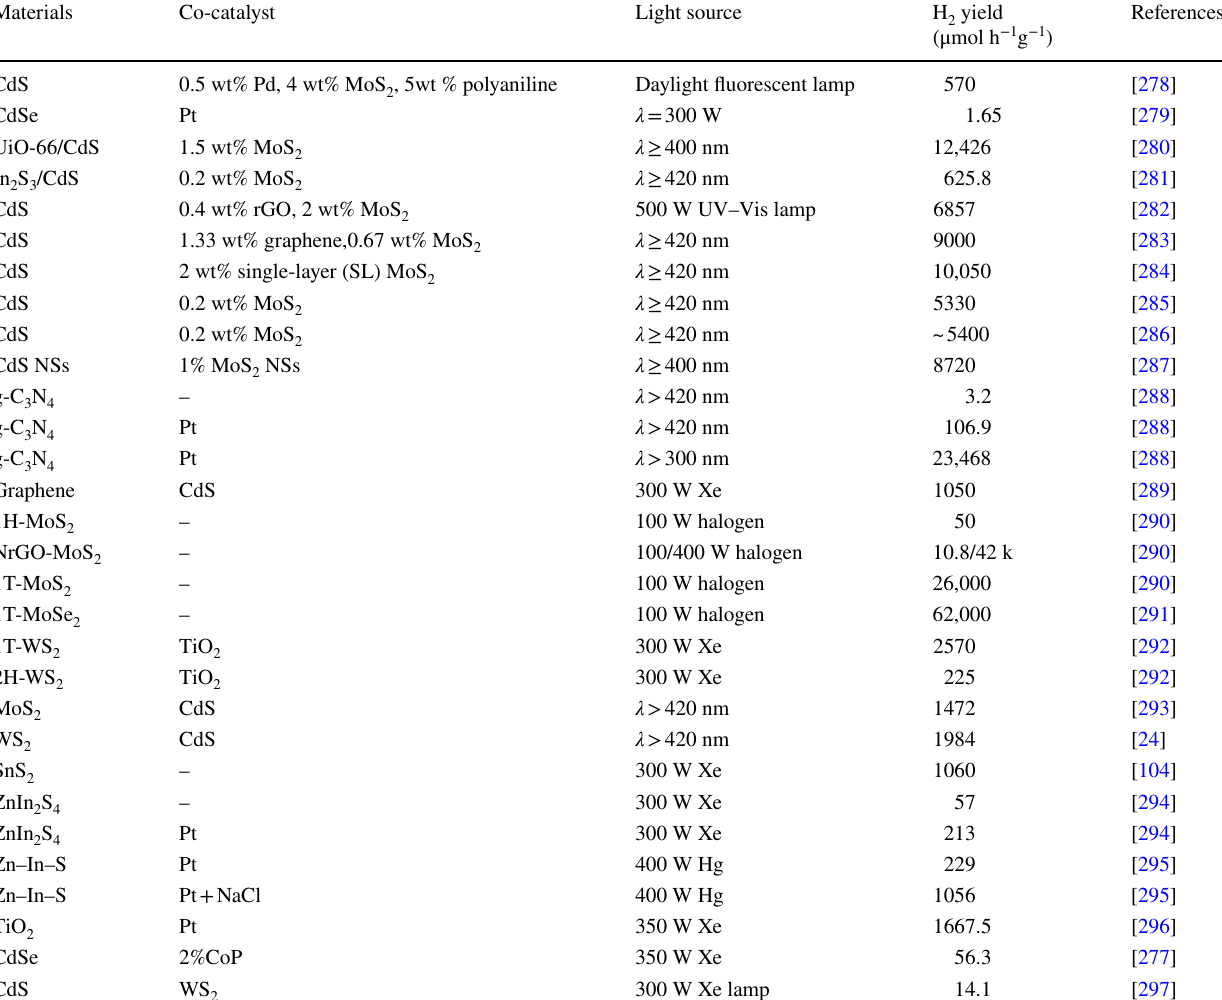
Table 1 H 2 ‑production based on